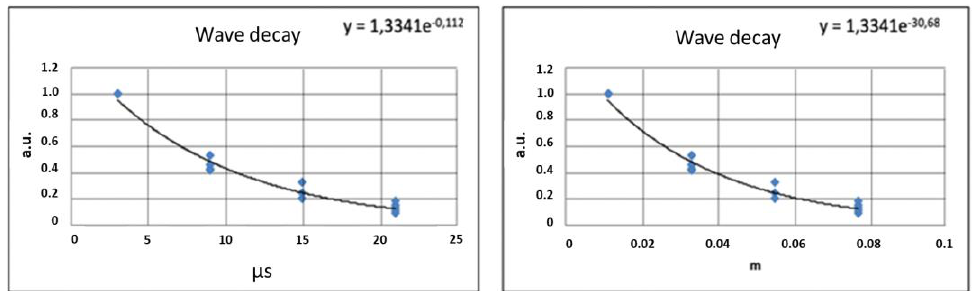
Figure 6. In the graph (on the left), the normalized wave pulse amplitude A (a.u. normalized) is displayed. On the right, is shown the length crossed by the wave, considering the evaluated sound speed inside the crystal. On the left, the pulse decay is reported as a function of time, on the right the displacement in a function of time.